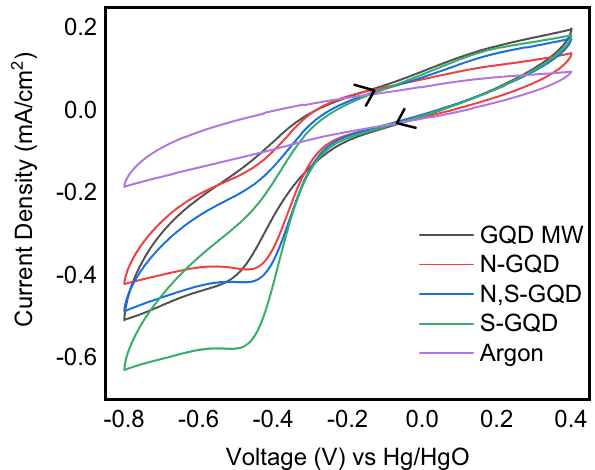
Figure 6. Comparison of Cyclic Voltammograms in O 2 saturated 0.1 M KOH at 100 mV/s in the potential window of − 0.8 to 0.4 V; working electrode: Glassy Carbon, Counter electrode: Pt coil, Reference electrode: Hg/ HgO, the fifth cycle is shown for all the GQDs. A blank (base line) was taken with Argon purged KOH to make sure no impurities are there while doing the